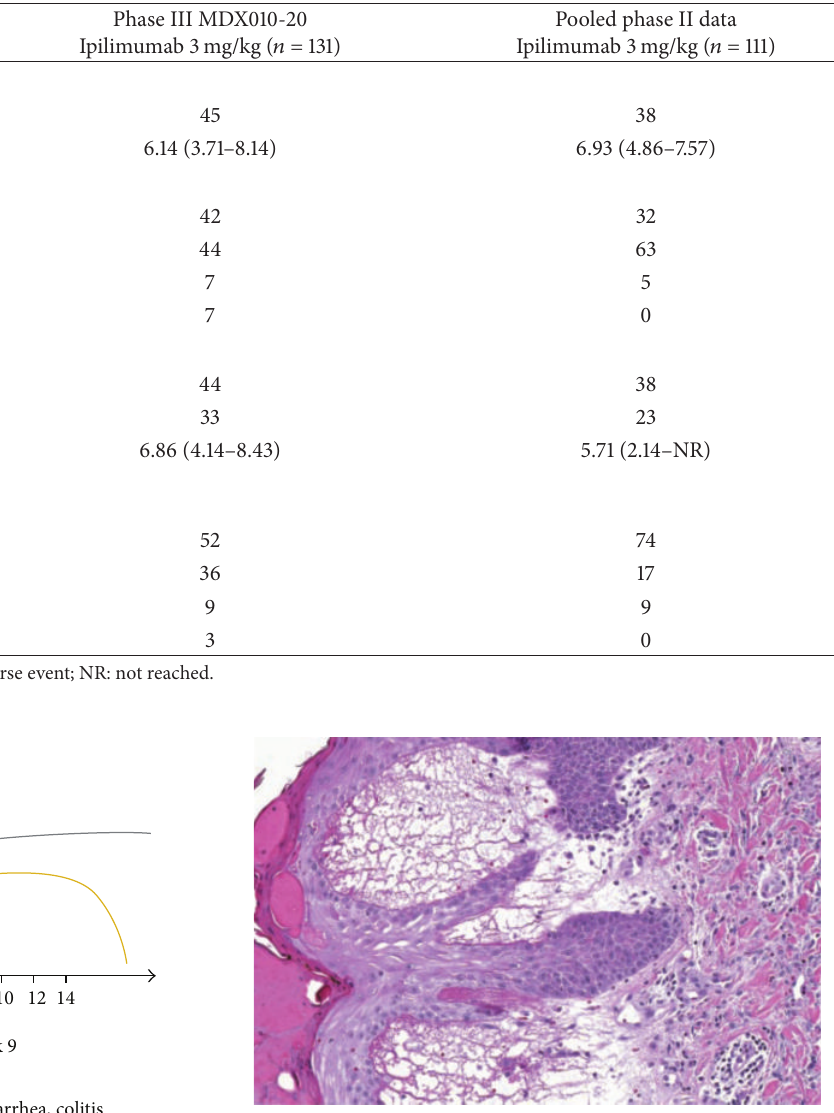
Table 3: Time to onset and resolution of irAEs in phase III and pooled phase II trials [25].